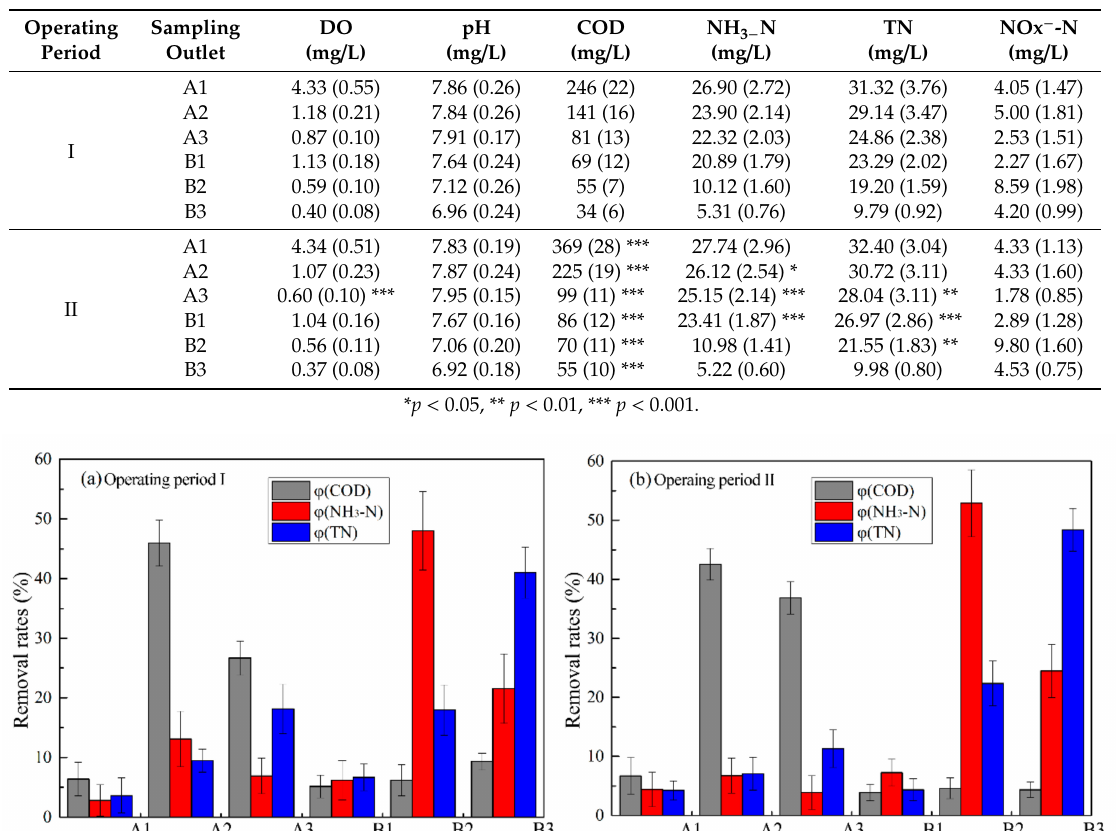
Table 2. Characteristics of wastewater parameter along the filter under two organic loads.